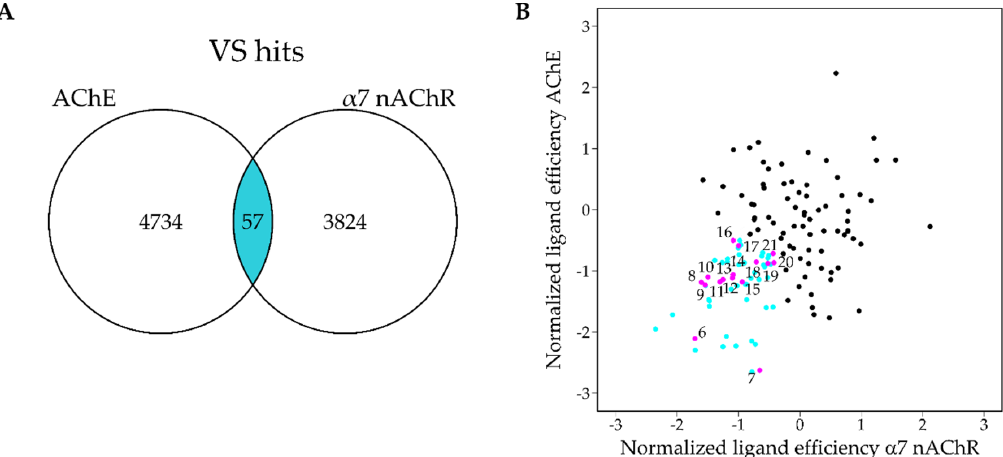
Figure 6. Venn diagram of AChE and α 7 nAChR screening hits in the 0.5 quantile of normalized ligand efficiencies. ( B ) Scatterplot of normalized, strain-corrected ligand efficiencies. Compounds which are in the 0.5 quantile are colored blue and tested compounds are labeled as indicated Table 1 and shown in magenta.